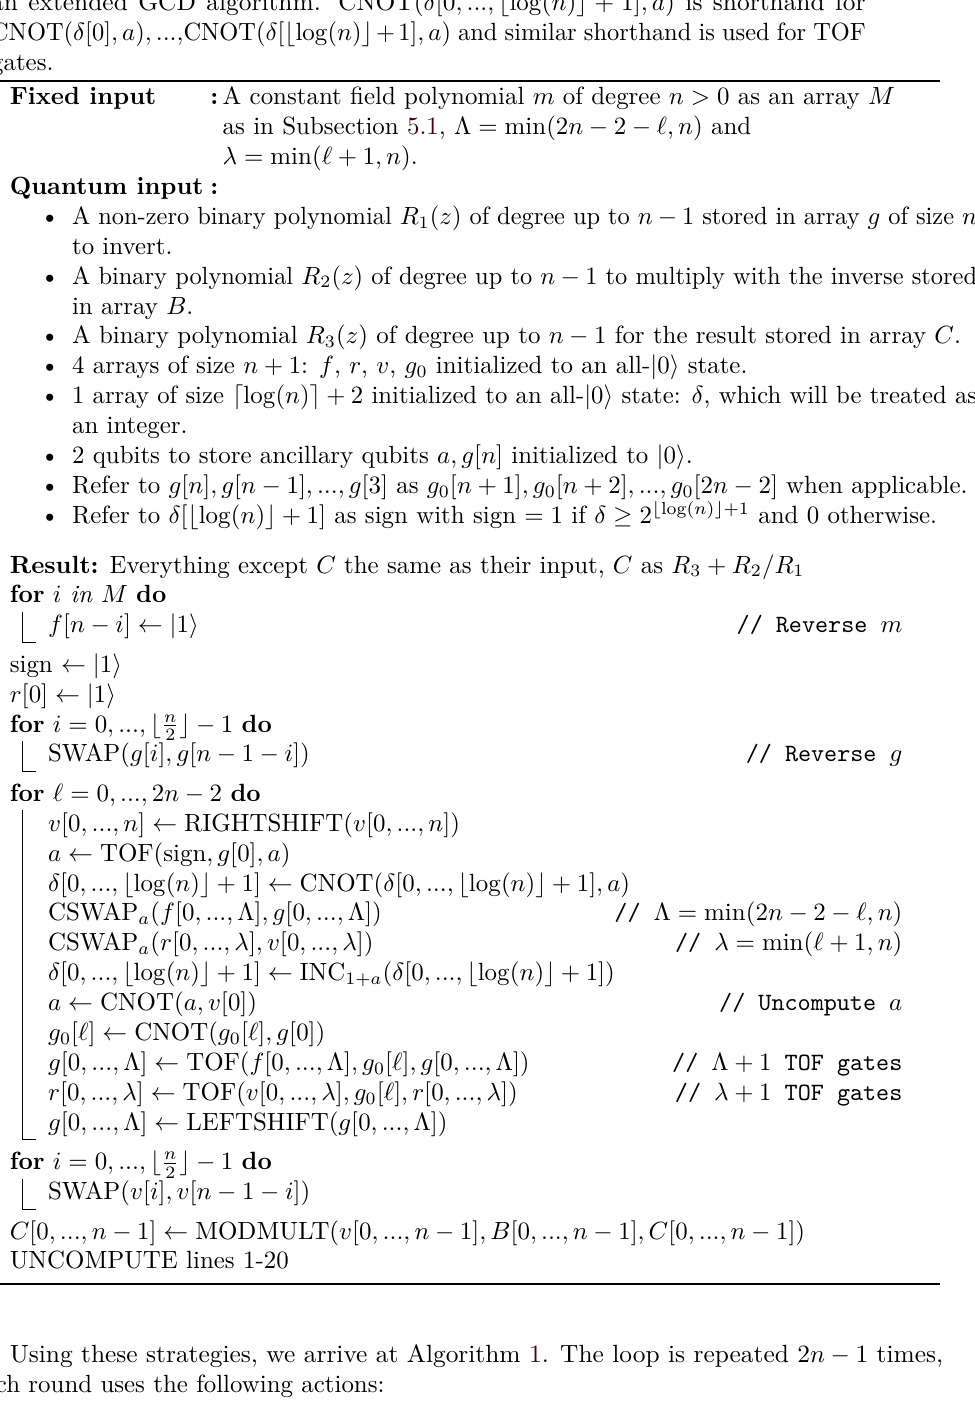
Algorithm 1: GCD_DIV. Reversible algorithm for division using inversion with an extended GCD algorithm. CNOT( δ [0 , ..., b log( n ) c + 1] , a ) is shorthand